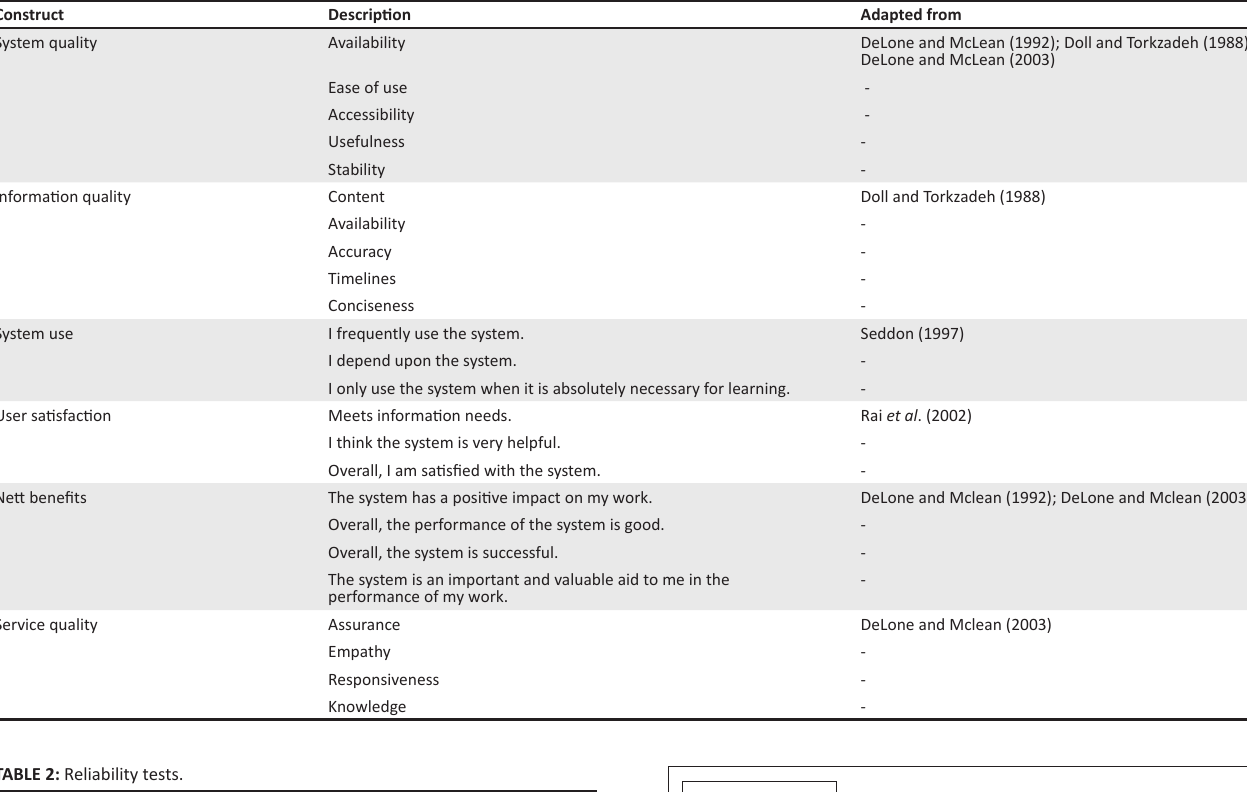
TABLE 1: Survey instrument constructs. Construct